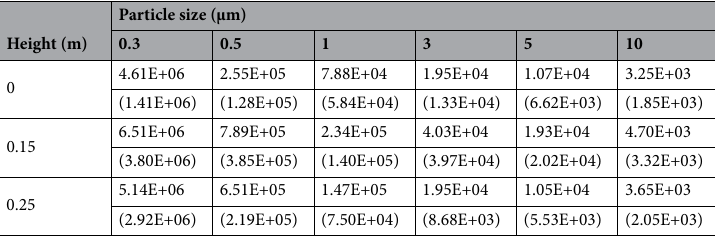
Table 1. Arithmetic mean (SD) particle count detected across all positions by height and particle size.